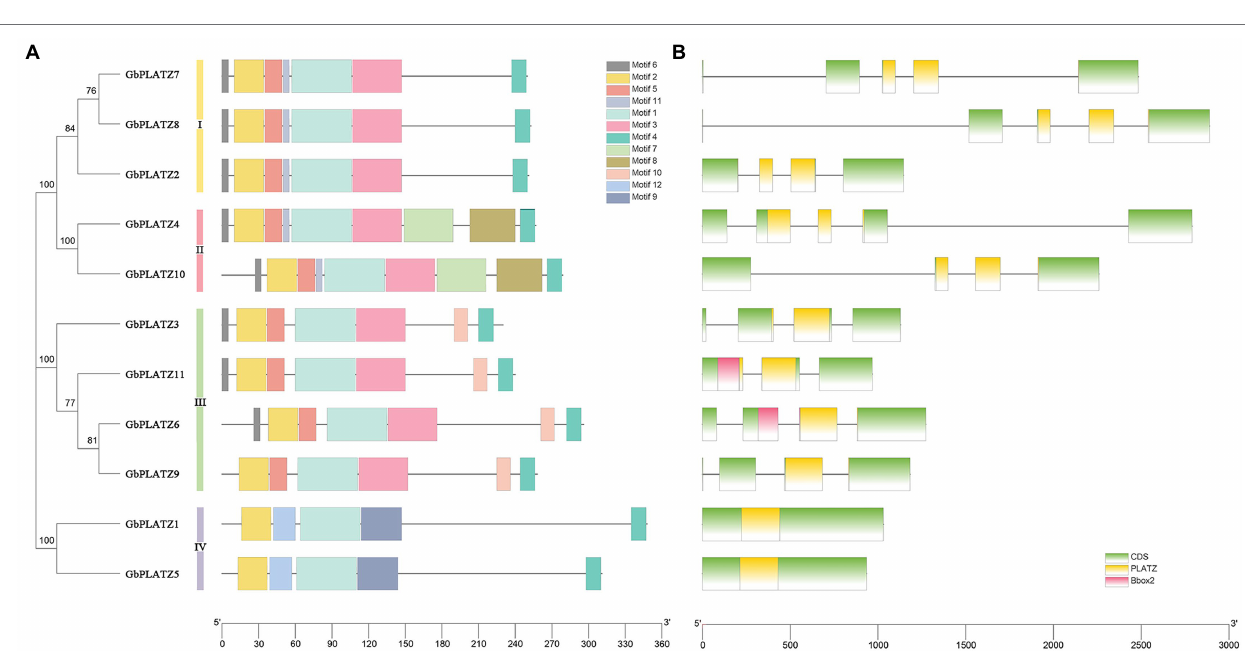
FIGURE 4 | Motif structure, gene structure, and family conservation analysis of GbPLATZ s. (A) The 12 MEME motifs are similar within groups and different between groups. (B) According to genome annotation data, GbPLATZ gene structure, and batch-SMART analysis, the type and location of the conservative domain are presented here, with rectangles for exons, horizontal lines for introns, green for CDS regions, and other colors for corresponding conservative